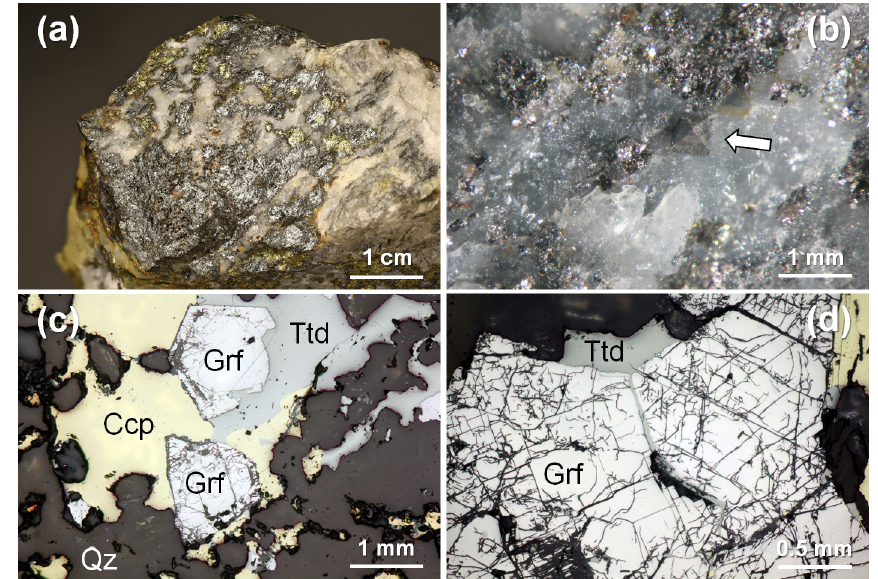
Figure 2. The studied specimen from Contrada Zillì, Fiumedinisi, Messina, Sicily (Italy). (a) Black compact metallic mass of tetrahedrite- (Fe) with admixed minor gersdorffite and yellow chalcopyrite in quartz. (b) Gersdorffite, octahedral crystal (indicated by the white arrow), less than 1mm in size, in quartz. (c) Subhedral crystals of gersdorffite (Grf) associated with chalcopyrite (Ccp) and tetrahedrite-(Fe) (Ttd), in quartz (Qz). Reflected light microscopy, Nicol //. (d) Details of subhedral crystals of gersdorffite showing its good { 100 } cleavage. Reflected light microscopy, Nicol